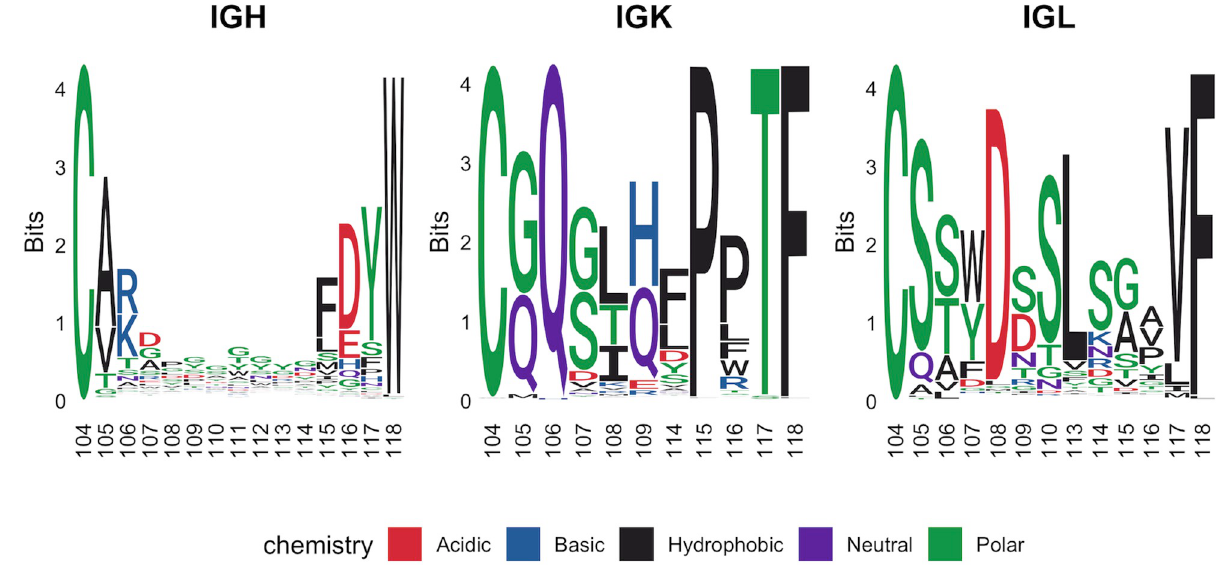
differences in V gene usage between either group level comparison for IGH (S7 Fig). Notably, paired IGH cases (i.e. cases with T1 and T2 samples) did not necessarily cluster together. As with the healthy controls, IGHV3-38 and IGHV4-1 were the most abundant IGHV genes and IGHJ4 was the most abundant IGHJ gene. For five of the six dogs included here, those that were dominant for IGHV3-38 or IGHV4-1 at T1 were either dominant for the same one at T2 or usage at T2 was balanced. One dog (D02640) was dominant for IGHV4-1 (25.6% of reads) at T1 but was dominant for IGHV3-38 (36.0% of reads) at T2. The absence of V or J gene- based group-level clusters was also observed for IGK and IGL (S7 Fig [V gene segments] and S8 Fig [J gene segments]).